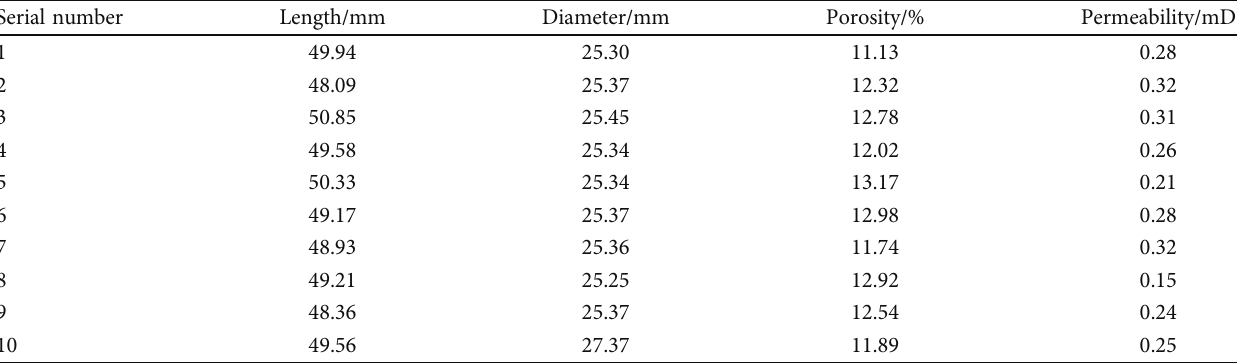
Table 1: Parameters of core samples.